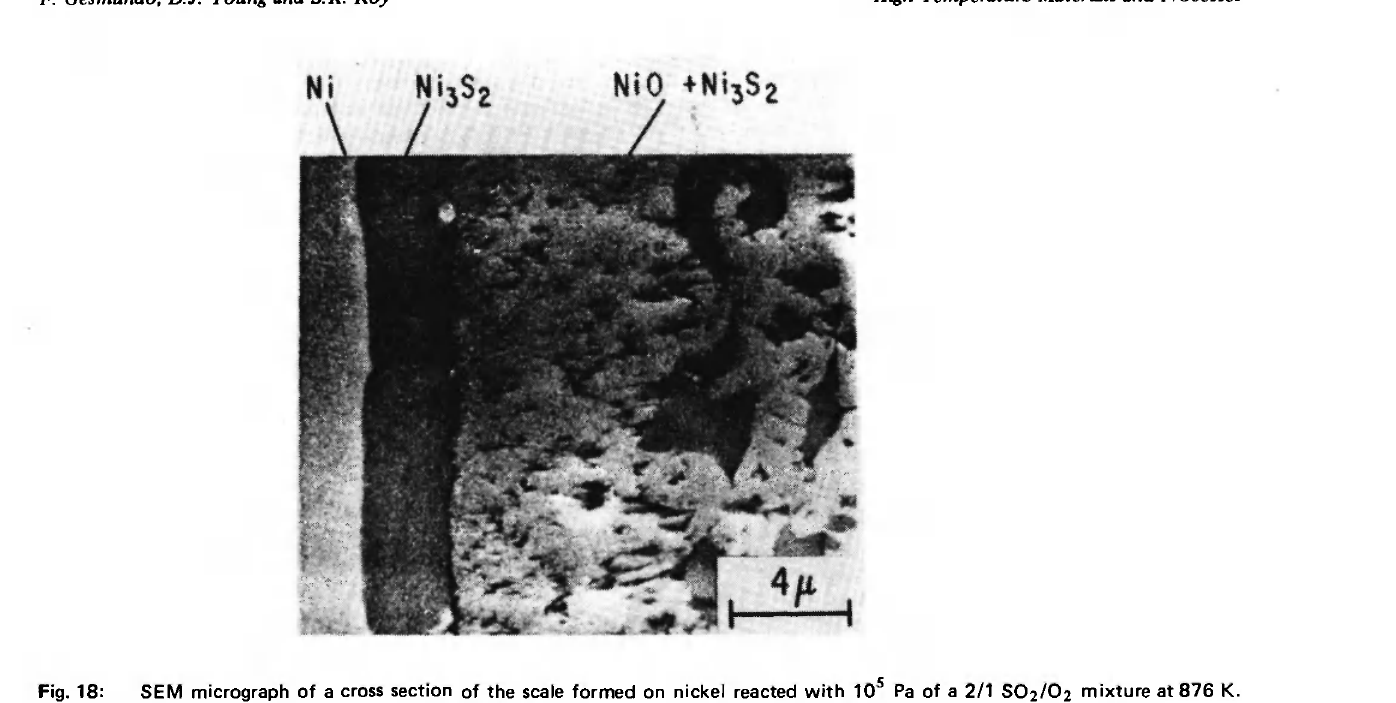
Fig. 18: SEM micrograph of a cross section of the scale formed on nickel reacted with 10 s Pa of a 2/1 SO2/O2 mixture at 876 K. Dark phase = sulfide, light phase = NiO /67/. Reprinted by permission of the publisher. Metallurgical Transactions.